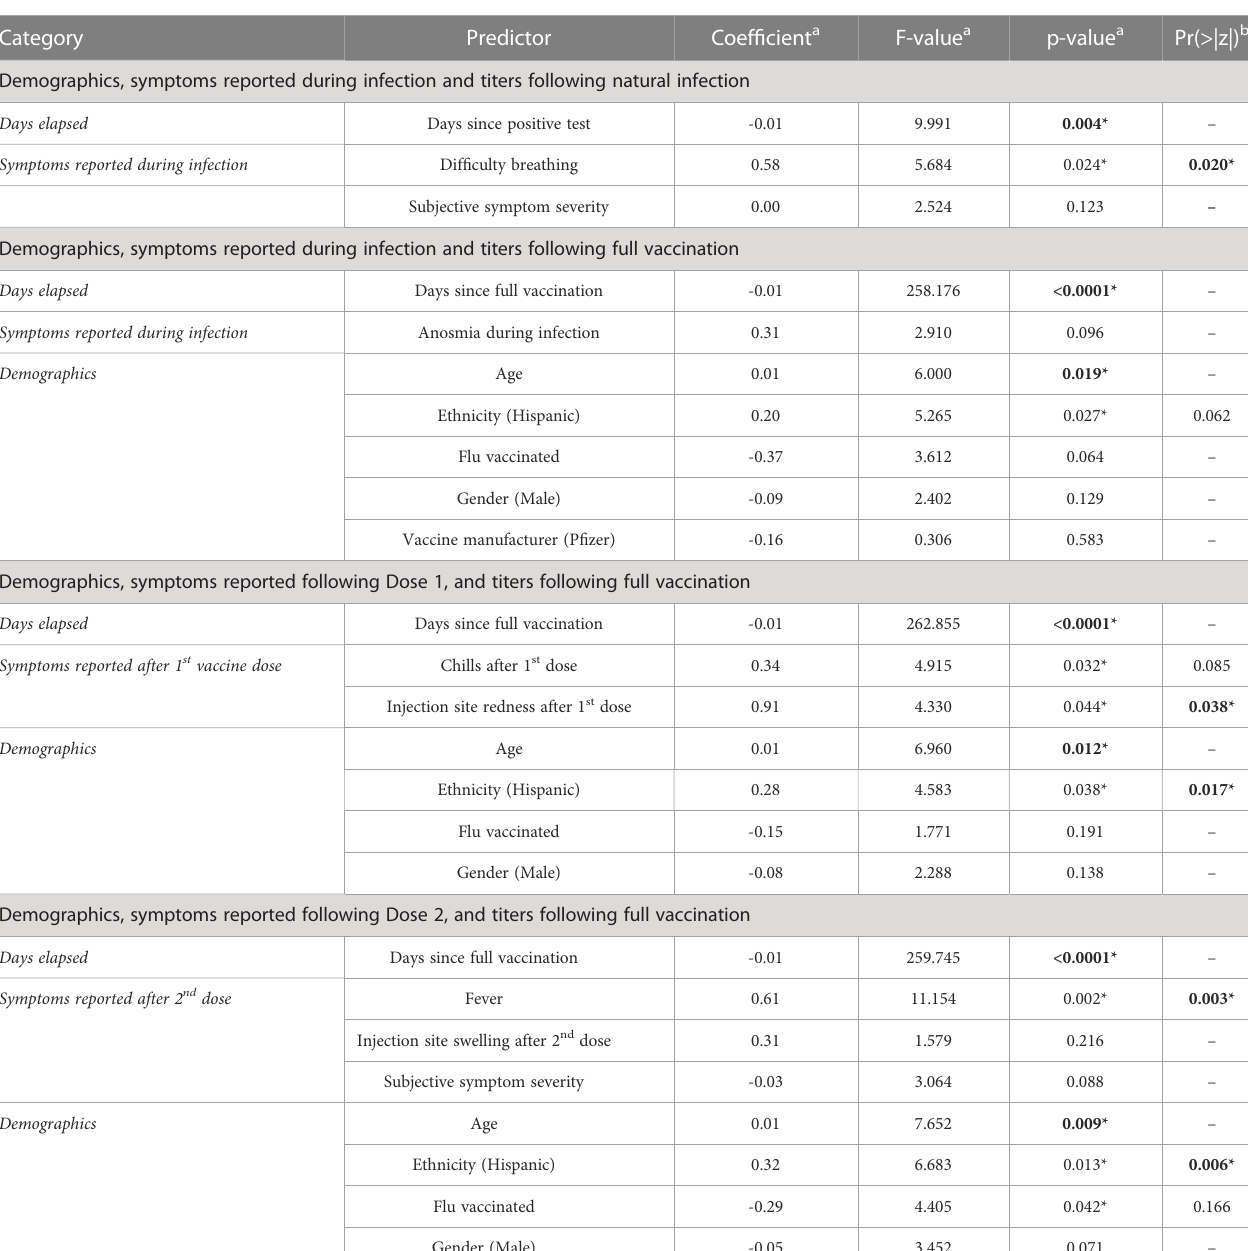
TABLE 3 Symptoms and demographic factors in fl uence antibody responses following natural infection and full vaccination.